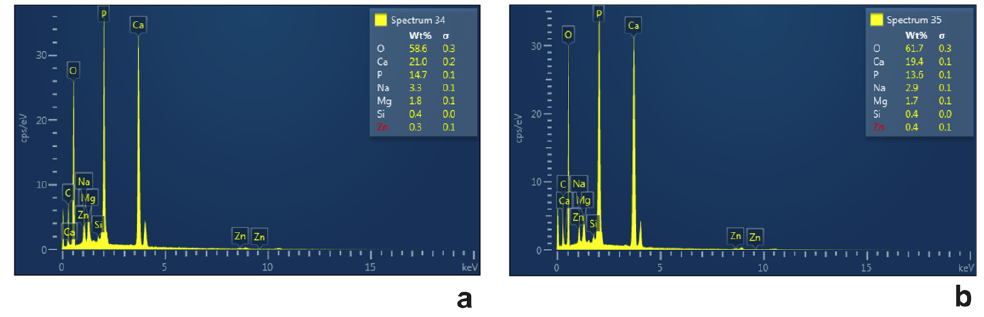
Figure 6. Example spectra of X-ray microanalysis associated with scanning electron microscopy recorded on Chlorella sp. cultivated for 6 days in 70%-diluted centrate stream. In ( a , b ) two representative spectra recorded from different areas of algae samples are reported. The box at the top right of the spectra images shows the % areas of the elements detected during the analysis.